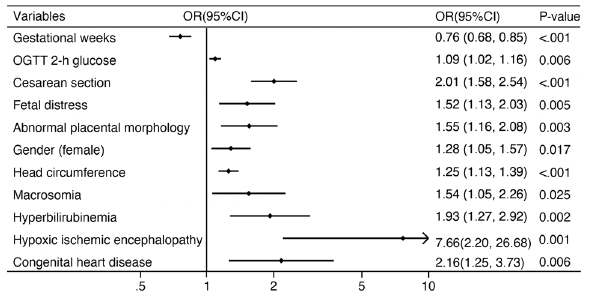
Figure 1. Maternal factors and neonatal outcomes associated with neonatal hypoglycemia.